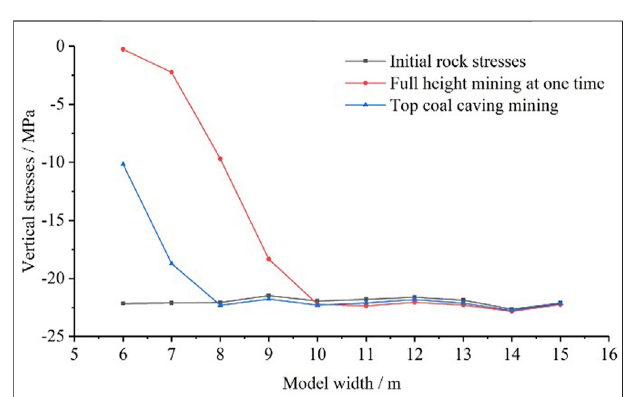
FIGURE 10 | Comparison of advanced stress after excavation.